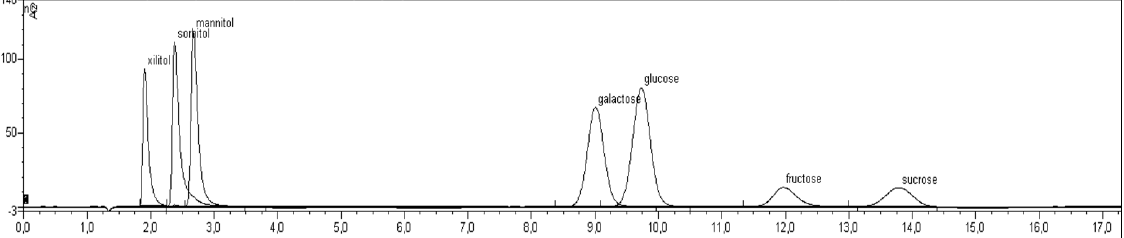
Figure A2. Mixture of standards chromatogram using CarboPac PA1 column .